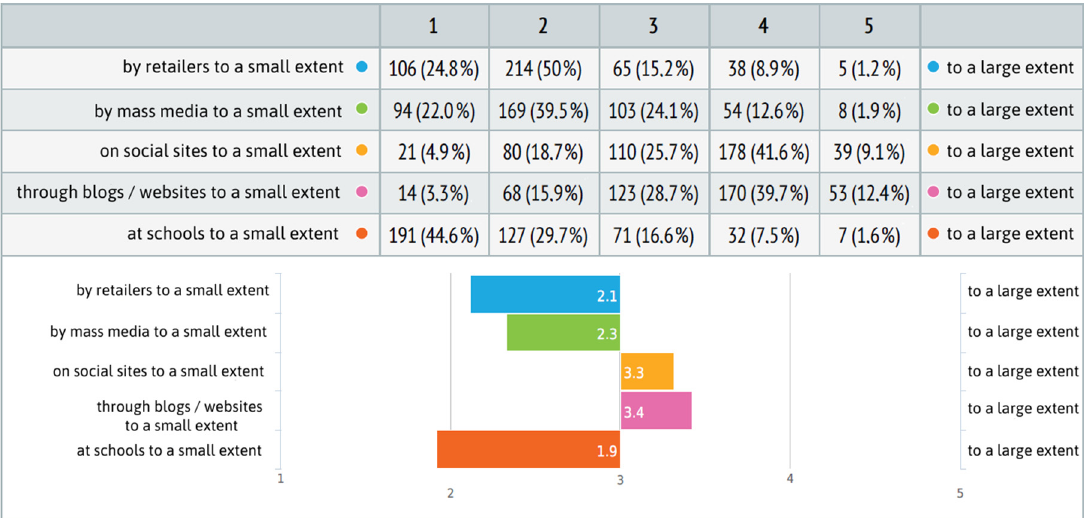
Figure 1. Extent of communication of the selected sustainable fashion subjects.